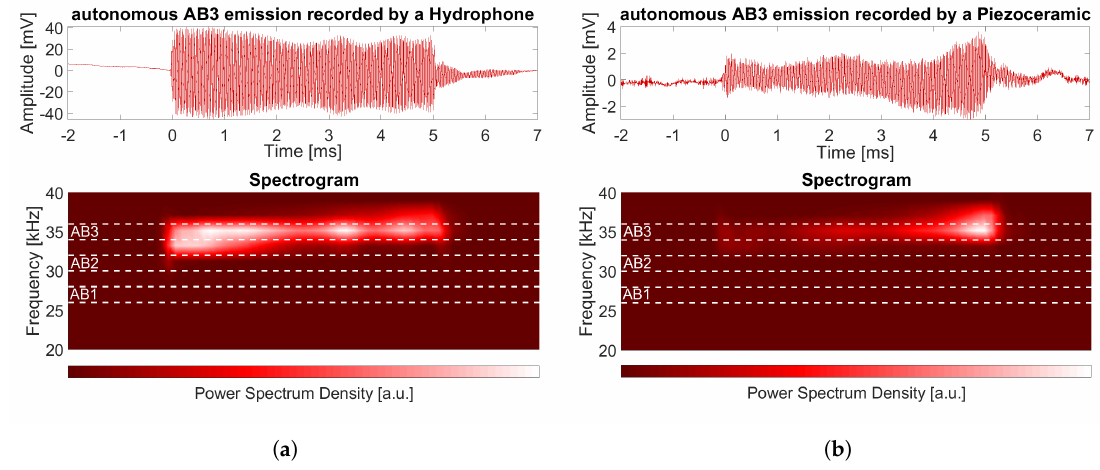
Figure 3. Pulse signal received (time scale is relative to detection time) by different DUs. The distinction of the Acoustic Beacon (AB) emitter is clearly observed in the spectrogram. ( a ) The AB pulse recorded by a hydrophone and its spectrogram. ( b ) The AB pulse recorded by a piezoceramic sensor in the lowest DOM (Floor 1 in Figure 1a) and its